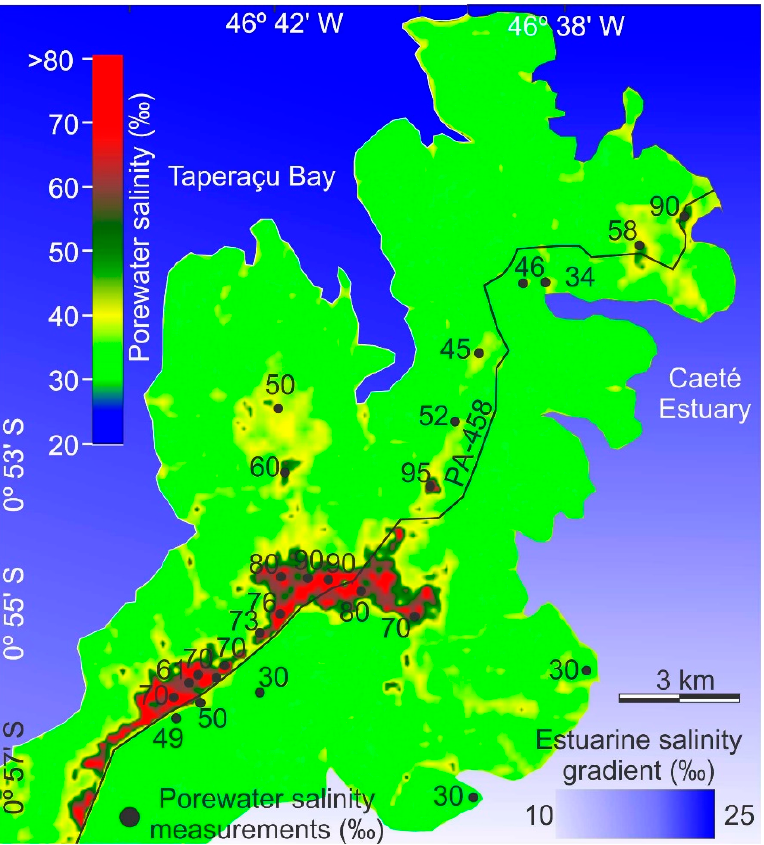
Figure 3. Sediment porewater salinity in the Bragança Peninsula based on regressions between measured porewater salinities obtained in 2002 and 2017 [30,31], and estuarine salinity gradient (modified from Lara and Cohen [32]).